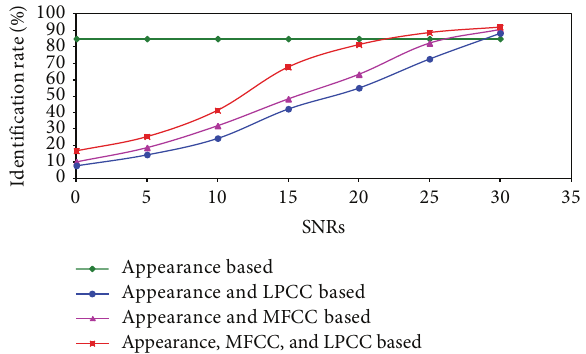
Figure 6: Result of various combinations of audio features with combined appearance and shape based facial